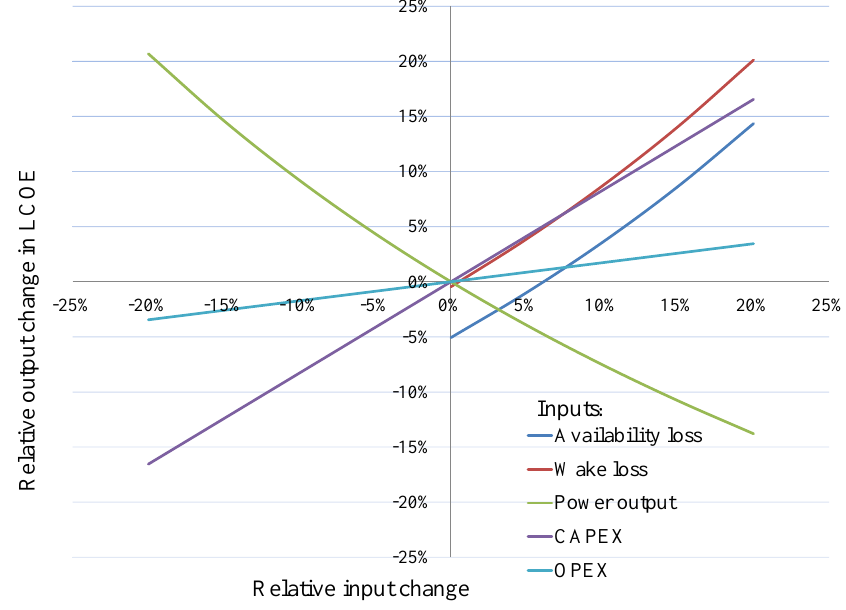
Figure 10. Sensitivity analysis of input parameters to levelized cost of energy (LCOE) (10% WACC)